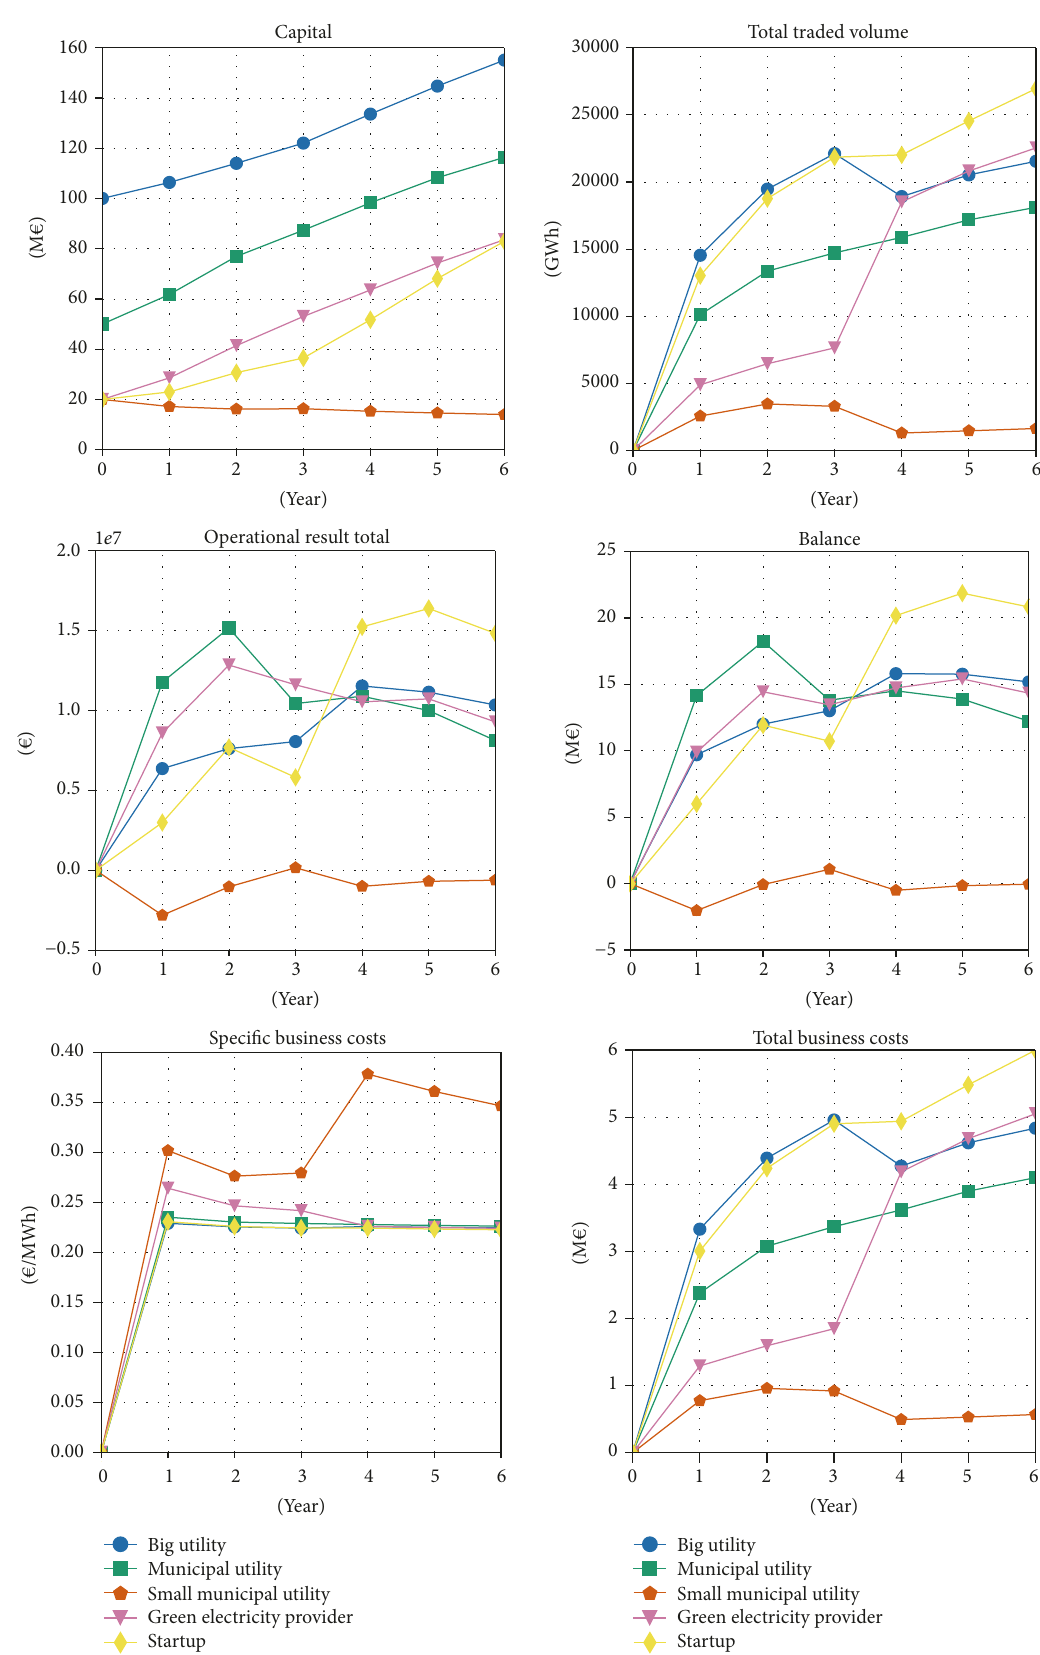
Figure 8: Scenario 1 results. The balance reflects all income and expenses at the market, including payments for balance energy, excluding the business costs. Business costs are considered in the operational